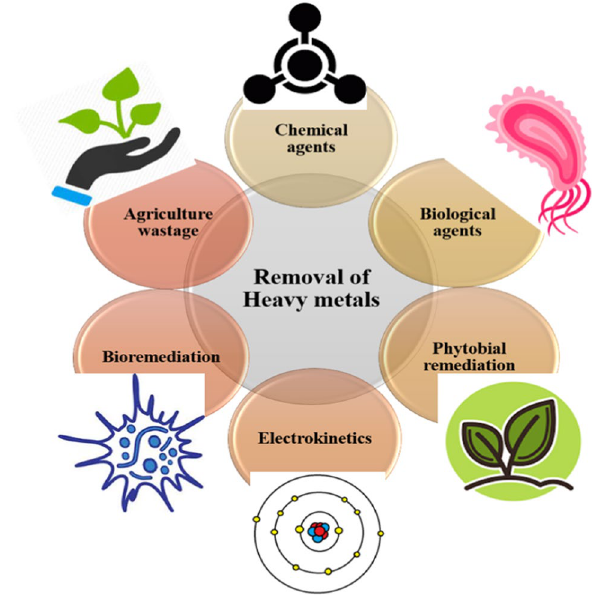
Fig. 3 Methods to remove heavy metals from the